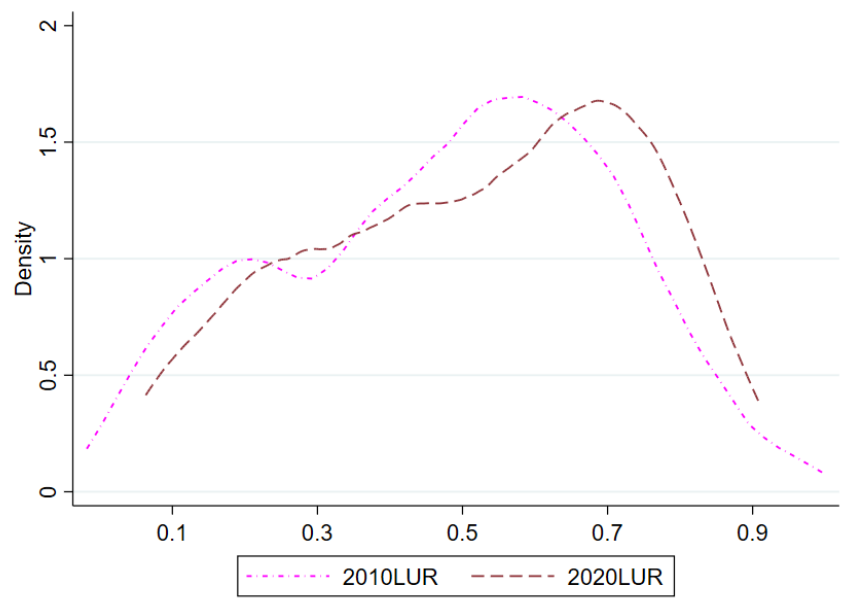
Figure 5. Estimation curve of land urbanization kernel density in Yangtze River Delta urban agglomeration from 2010 to 2020.